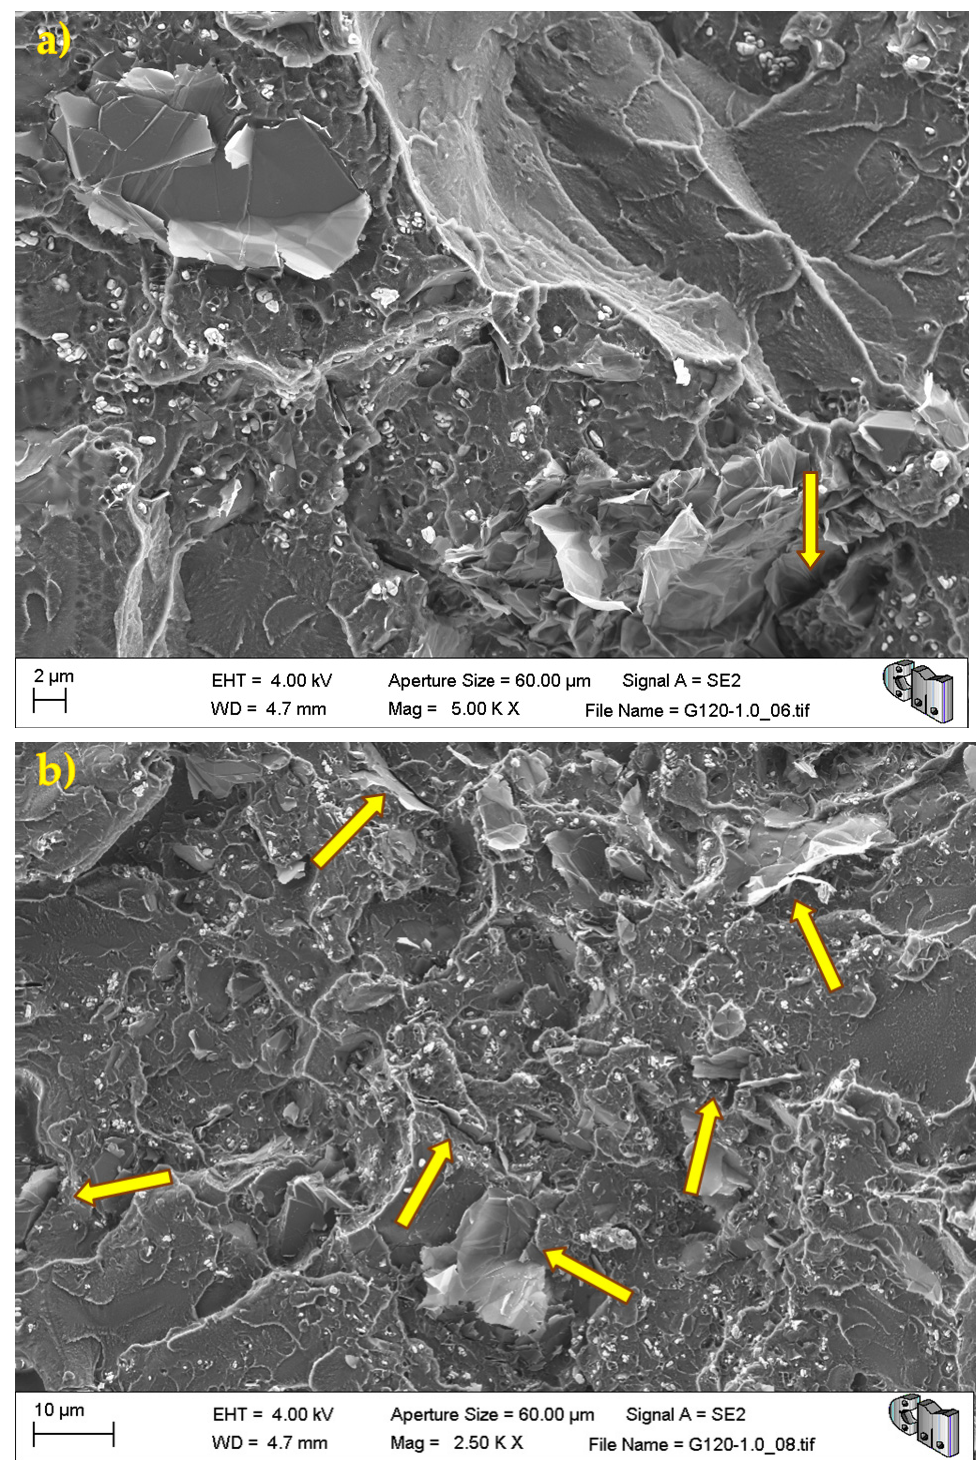
Figure 6. G120-1.0 fracture surface. The arrows indicate voids and flaws between the bone cement and the HRGO due to poor adhesion between both: ( a ) higher magnification, and ( b ) lower magnification.